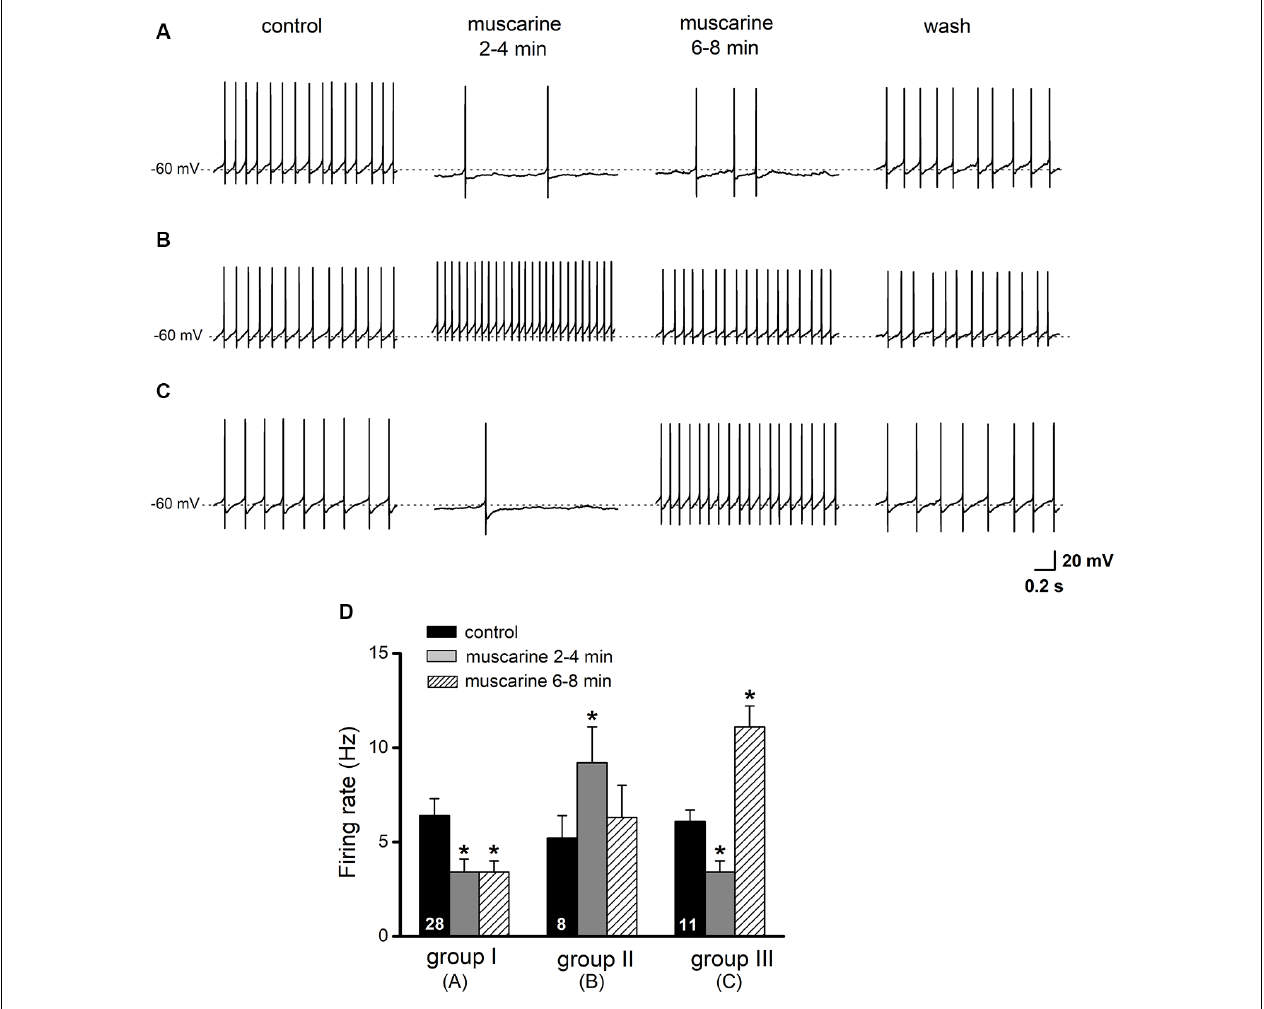
FIGURE 5 | Effects of muscarine on regular spiking glycinergic neurons in the preBötC. Current-clamp recordings of spontaneously active neurons were made in the presence of picrotoxin (100 µ M). Original traces in (A–C) illustrate examples of the three different response patterns of preBötC glycinergic neurons to muscarine application (10 µ M). Scale bar in (C) also applies for traces in (A,B) . Histograms in (D) summarize the early (2–4 min) and late (6–8 min) effects of muscarine on firing rate. Groups are based on the responses shown in (A–C) and are further described in the “Results” section. The numbers inside the columns indicate the number of neurons of the respective groups. ∗ p < 0.05, compared to respective